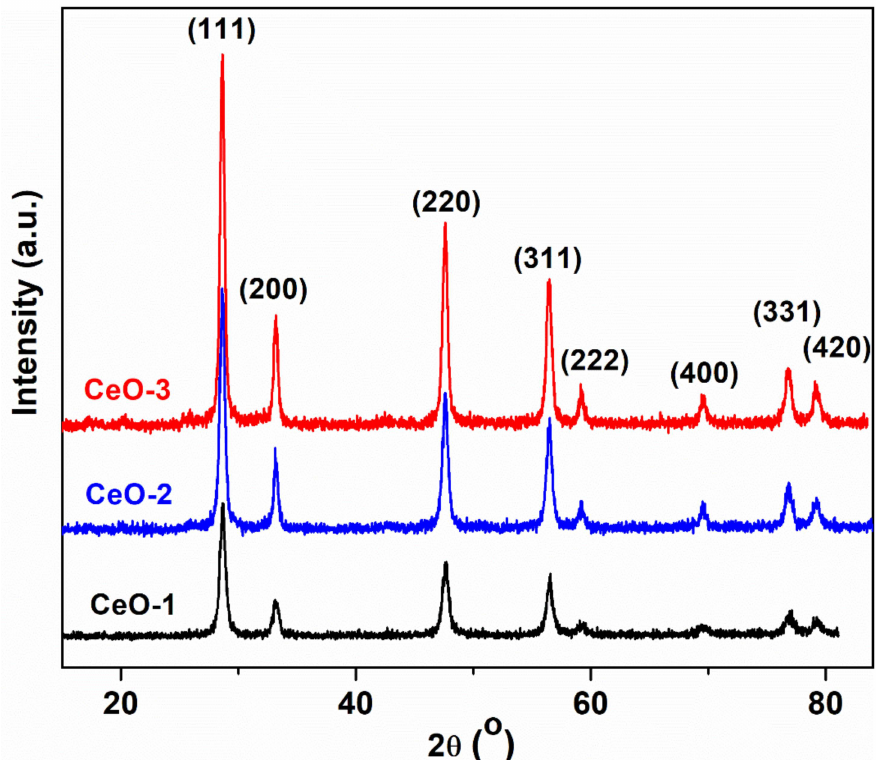
Figure 1. XRD patterns of cerium oxide nanoparticles.